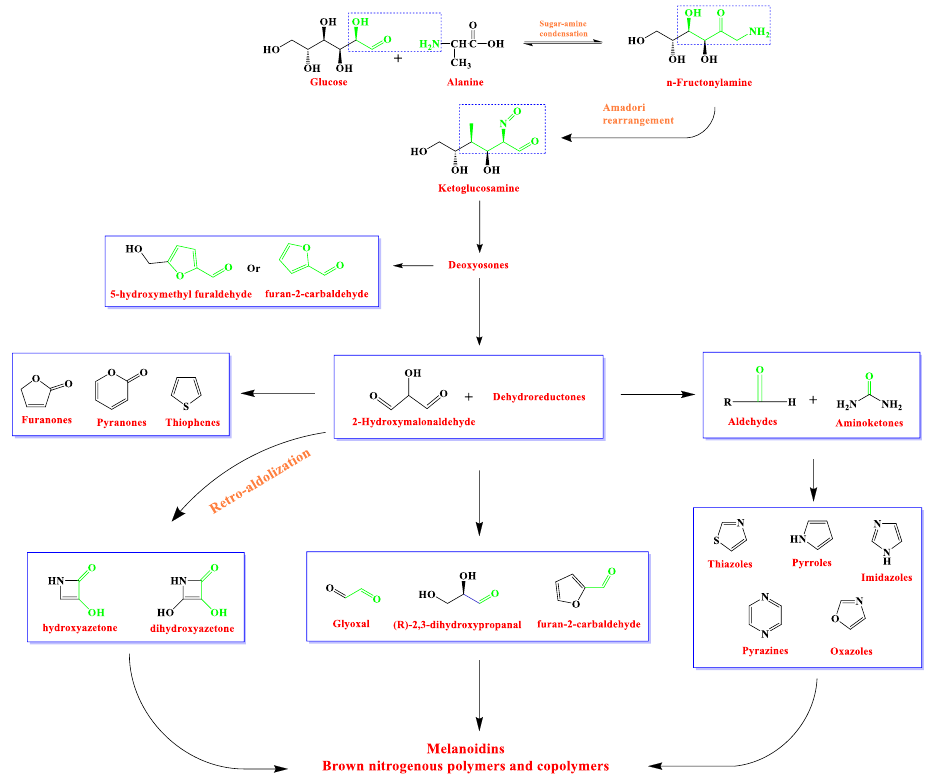
Figure 1. Maillard reaction